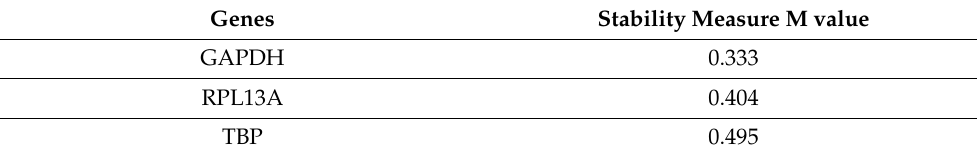
Table 1. Ranking of reference genes according to their expression stability by GeNorm. Genes